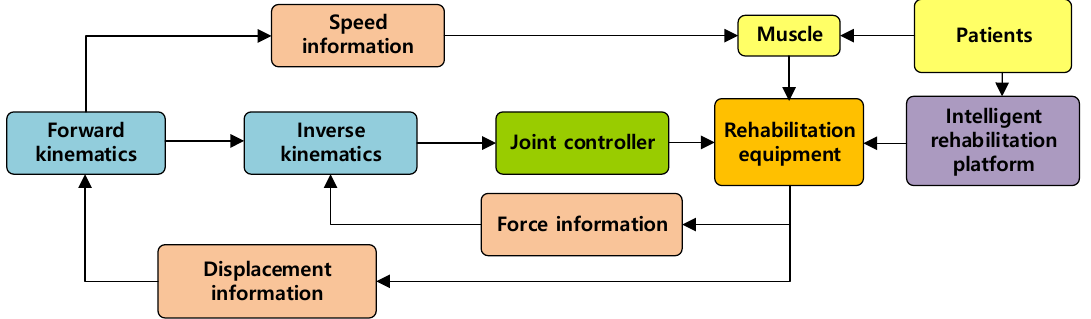
Figure 9. System control diagram of the active training mode.